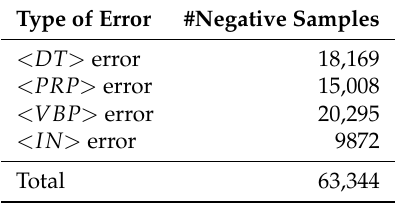
Table 5. Distribution of Tag-specific